Question: Name the type of graph shown.
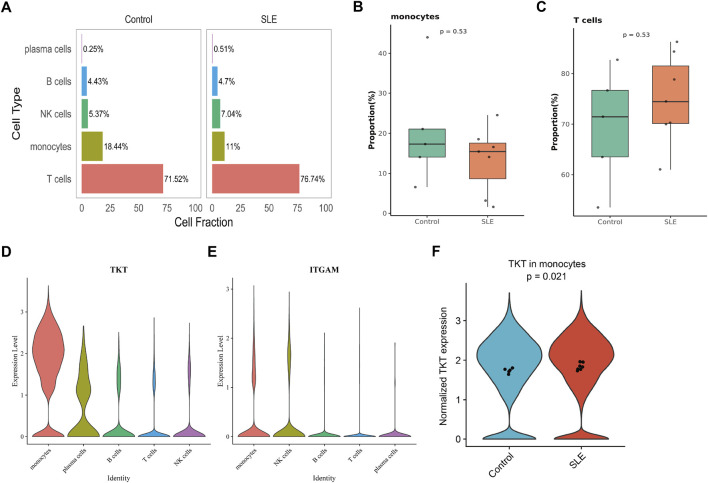
Answer: box